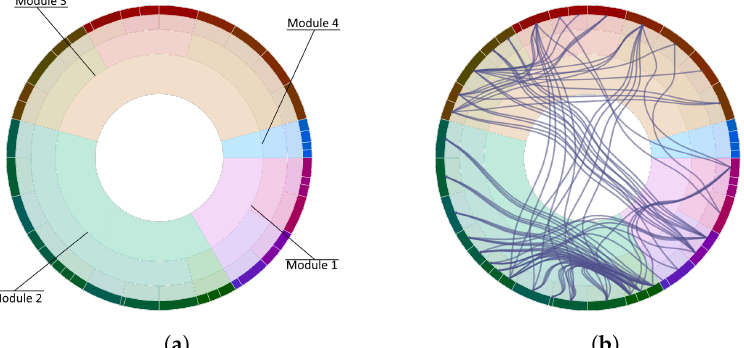
Figure 20. ( a ) Course hierarchy. Structure of the course contents created with Carbonic. The size of the leaves is proportional to the duration attribute. ( b ) Hierarchy with the network. Hierarchical structure and dependencies among